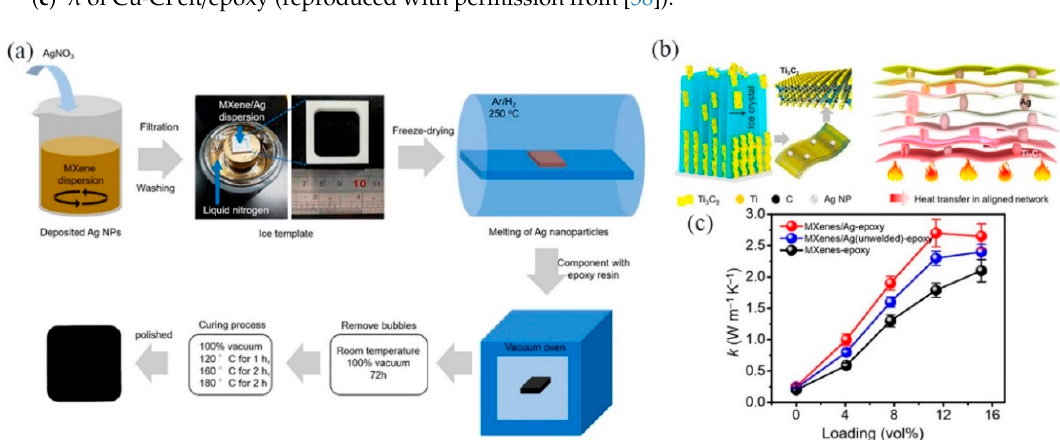
Figure 20. ( a ) Detailed flowchart of preparing the MXene / Ag-epoxy nanocomposites films. ( b ) 3-D networks and heat transfer and ( c ) λ of MXene / Ag-epoxy nanocomposites films (reproduced with permission from [165]).